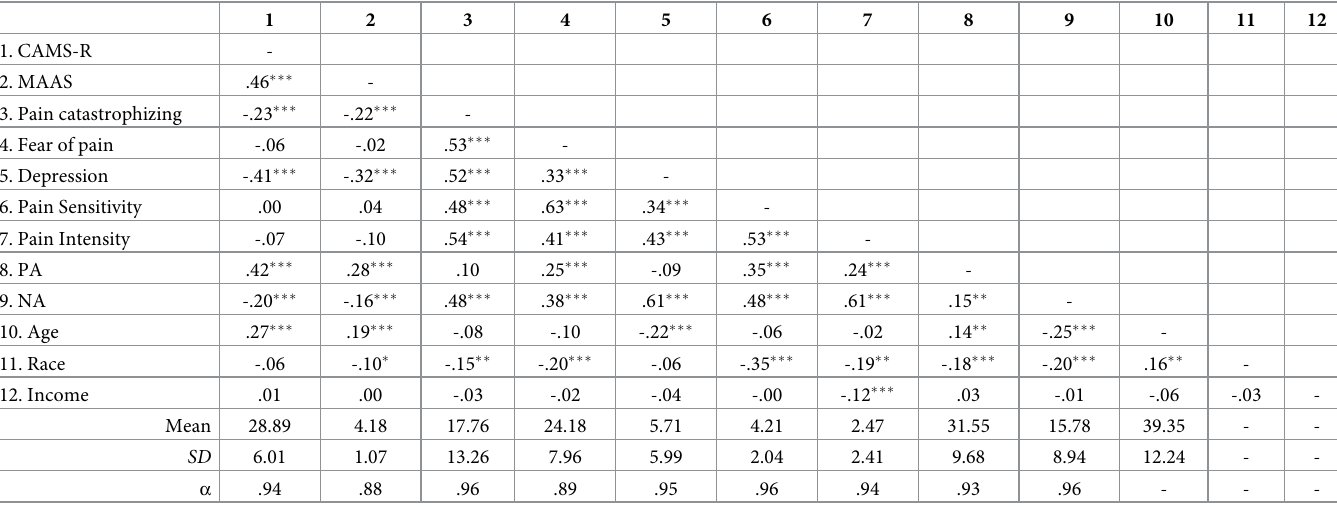
Table 1. Descriptive statistics, Cronbach’s alphas, and bivariate correlations for Study 1